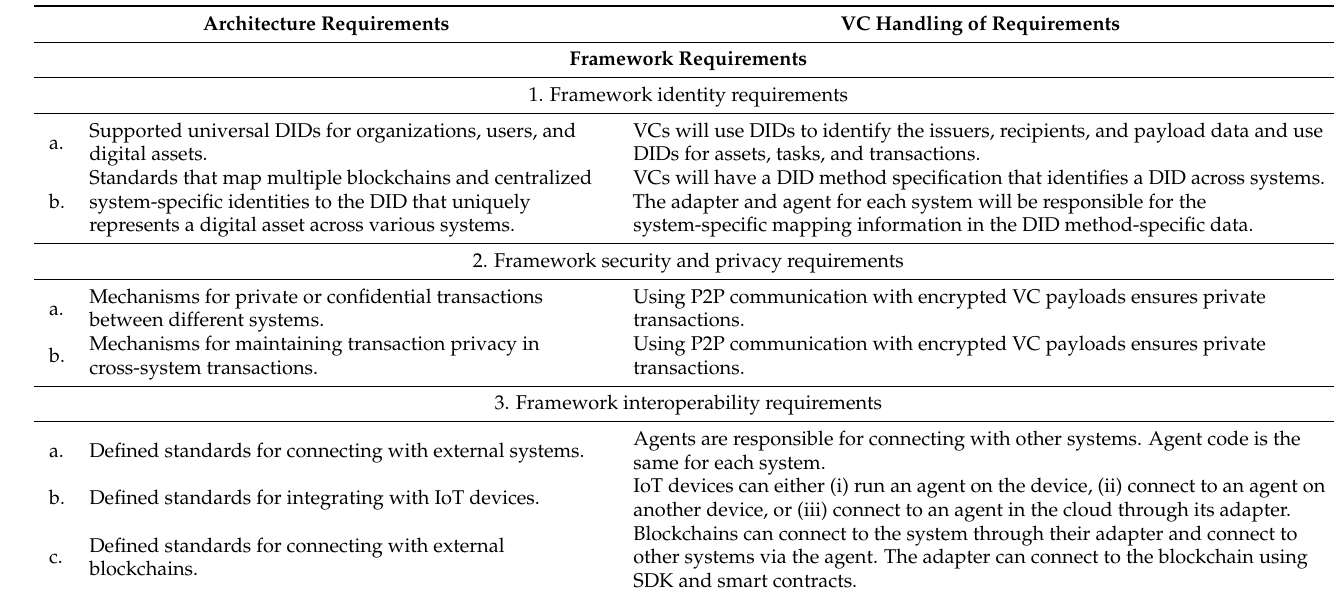
Figure 2. Decentralized Communication in a VC-Centric System. Below, Table 1 provides detailed architecture requirements in the left-hand column, while the right-hand column defines how these requirements can be met with our proposed VC-based architecture. Table 1. Architecture requirements and the VC